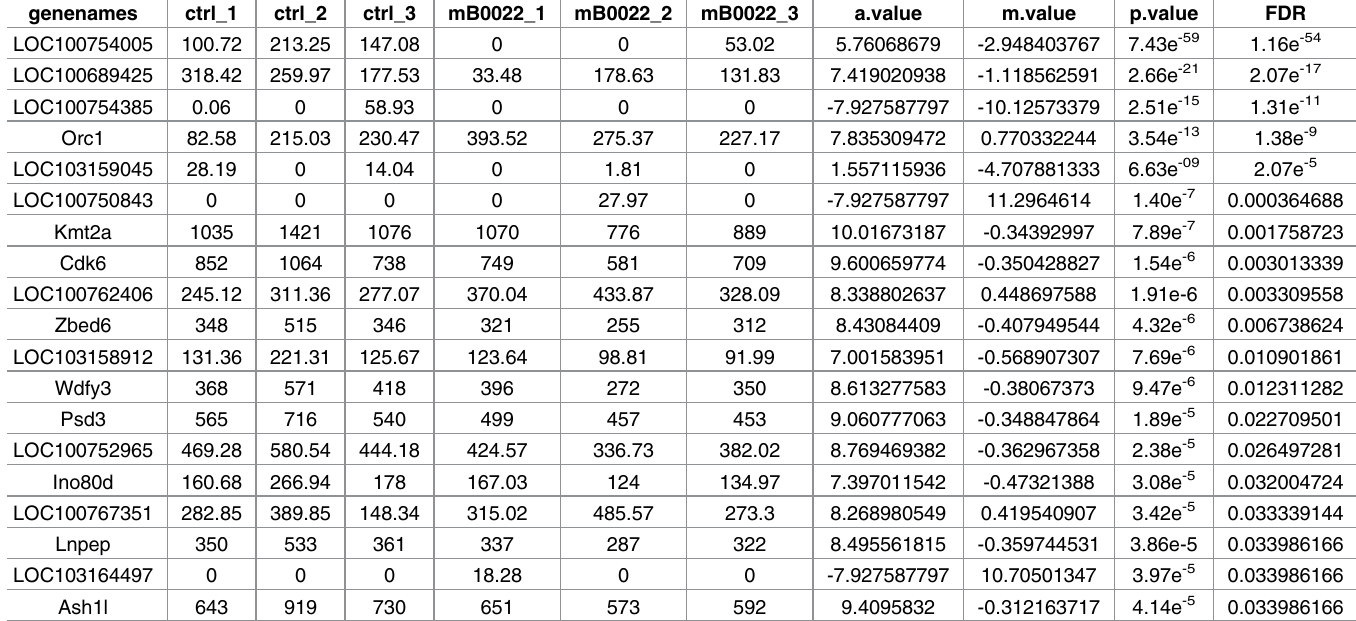
Table 1. Characterization of differentially expressedgenes in response to 0 or 0.22 μ M mahafacyclinB.